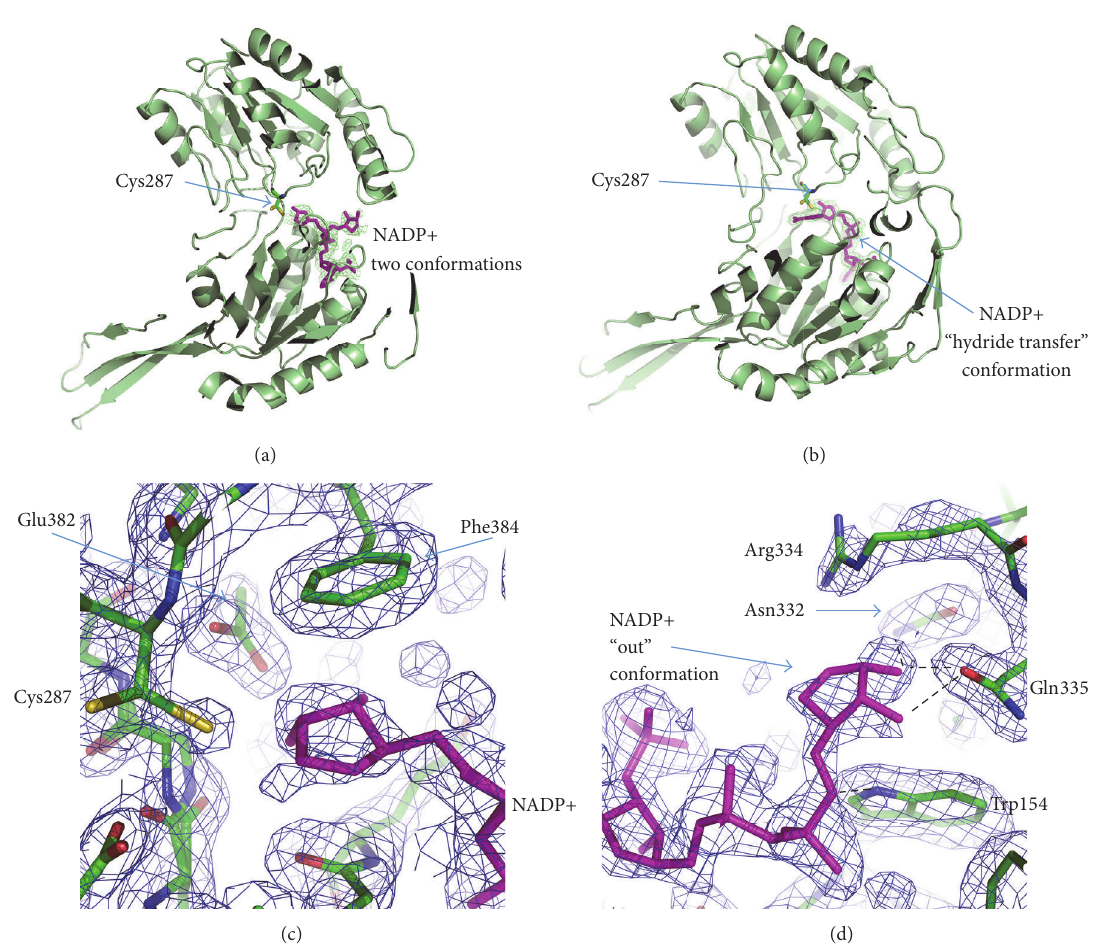
Figure 5: Different conformations of the coenzyme in the complexes with AlDHPyr1147. Coenzyme is in magenta, and AlDHPyr1147 is in green. (a) The coenzyme is in two conformations in the Holo-1 and Holo-2 complexes. The omit 𝐹 obs −𝐹 calc electrondensity map for the model Holo-2 around the coenzyme is contoured at 2.7 𝜎 and colored green. (b) NADP+ is in the “hydride transfer” conformation in the Holo-3 model. The omit 𝐹 obs − 𝐹 calc electron density map for the model Holo-3 around the coenzyme is contoured at 3 𝜎 and colored green. ((c) and (d)) The 2𝐹 obs − 𝐹 calc electron density maps for the AlDHPyr1147 model contoured at 1 𝜎 and colored blue. Hydrogen bonds are shown by dashed lines. (c) An enlarged view of coenzyme in the “hydride transfer” conformation in the active site of the Holo-1 model. (d) An enlarged view of coenzyme in the “out” conformation in the Holo-1